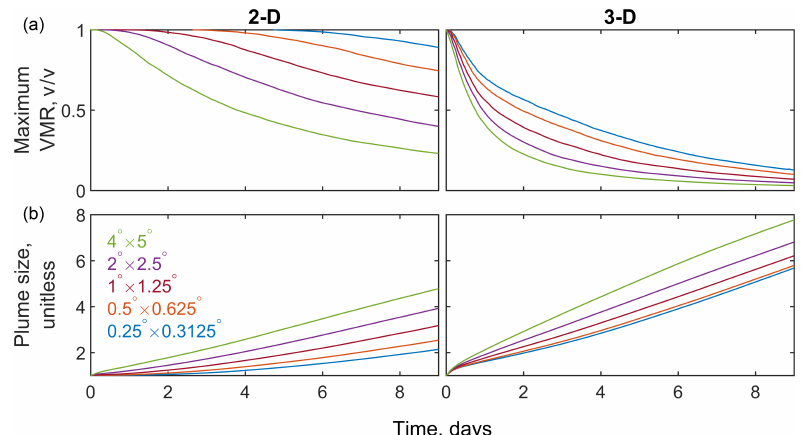
Figure 6. Maximum VMR (top panel) and plume size (bottom panel) as a function of plume aging time. Values are global averages for the ensemble of 90 plumes in Fig. 1 and are shown for 2-D and 3-D simulations at the different horizontal grid resolutions indicated in the